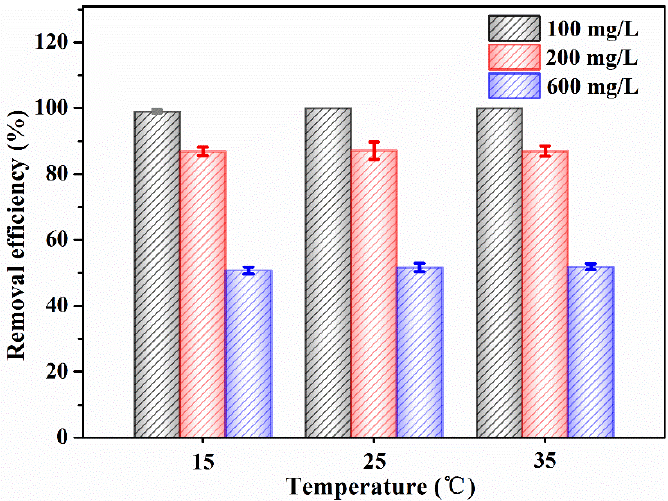
Figure 9. The influence of temperature on removal efficiency of RhB by CBC-Fe(II) (adsorbent dosage: 30 mg).